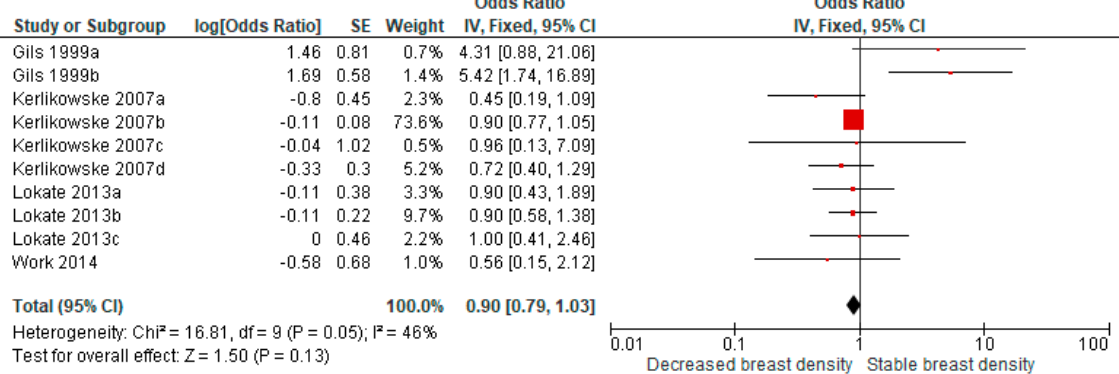
Figure 5. Pooled analysis for breast cancer risk in relation to decreased breast density over time (studies presenting odds